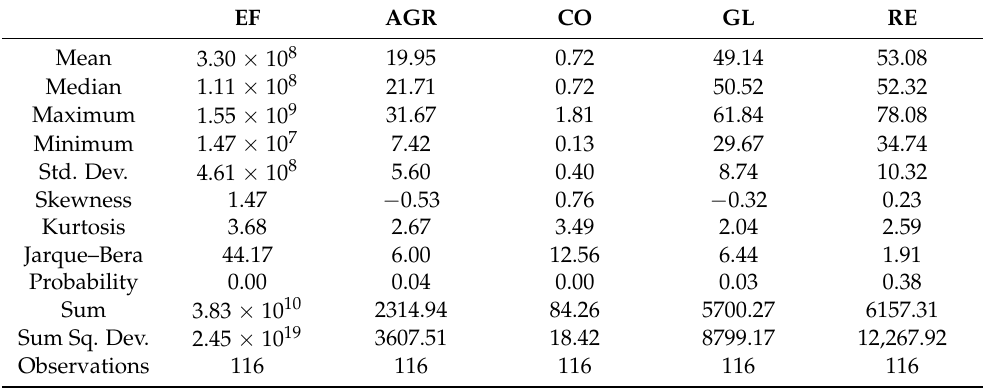
Table 2. Descriptive